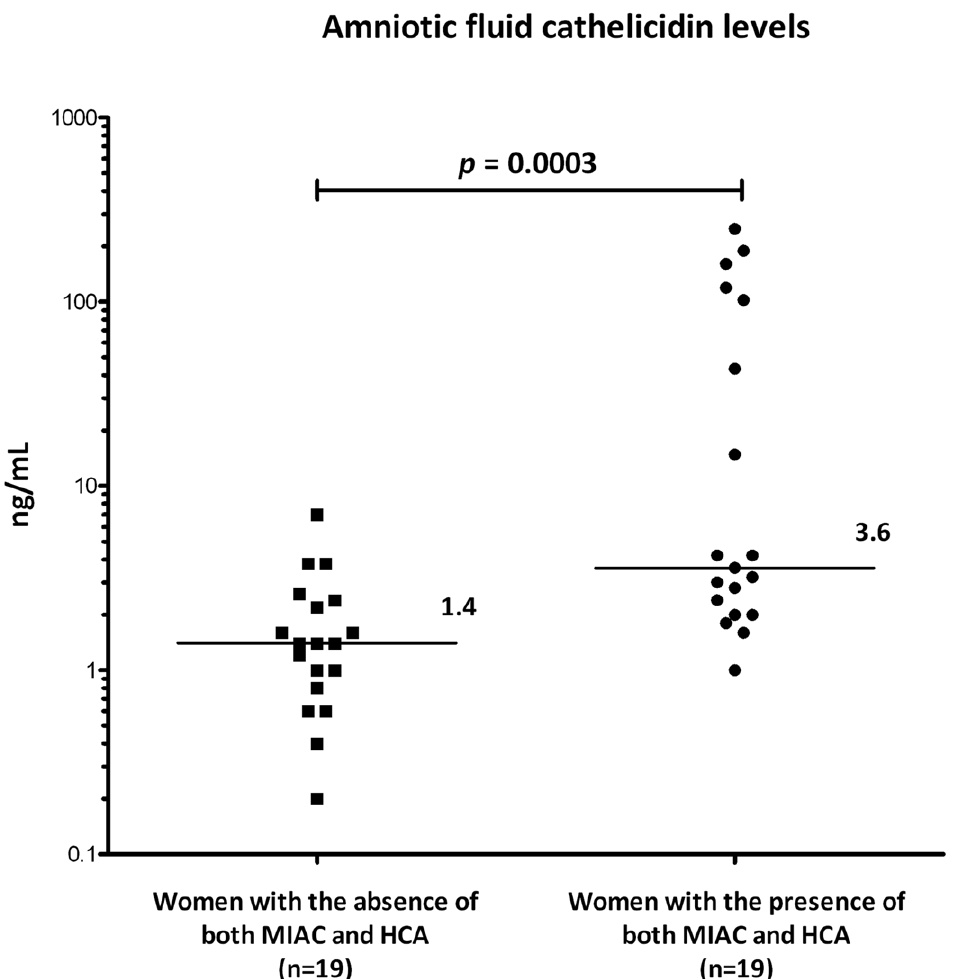
Figure 2. Verification of amniotic fluid cathelicidin levels. In concordance with the iTRAQ findings, women with confirmed MIAC and HCA enrolled in the exploratory phase had significantly higher amniotic fluid cathelicidin concentration than women in whom both conditions were ruled out. Cathelicidin levels were measured using a commercial ELISA kit. Values were evaluated using nonparametric Mann-Whitney U test. Graph represents individual values, horizontal bars indicate median values. Abbreviations: MIAC = microbial invasion of the amniotic cavity; HCA = histological chorioamnionitis.